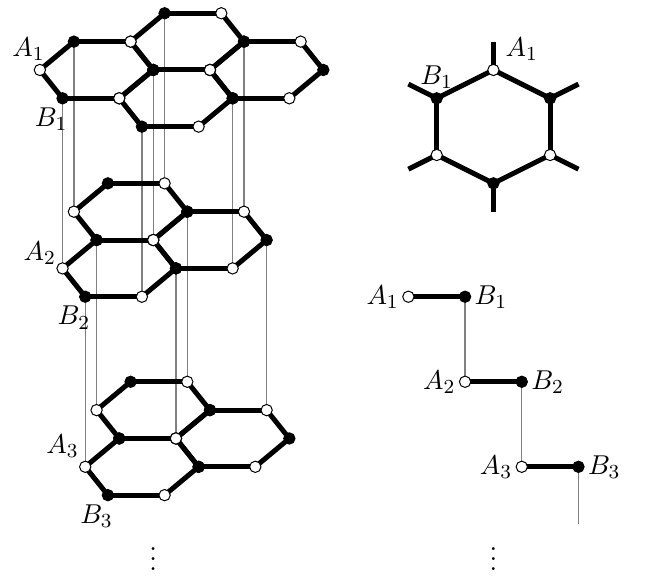
Figure 1 . The atomic structure of ABC-MLG. The white dots are for the A sublattice, and the black dots are for the B sublattice. Lines denote bondings. Thick black lines are for nearest neighbor couplings t within the intralayer, and thin gray lines are for couplings t ⊥ of interlayer vertical bonds k that couples B j and A j +1 for j = 1 , 2 , · · · , N − 1 . we call this kind of stacking order ABC-stacking or rhombohedral stacking.